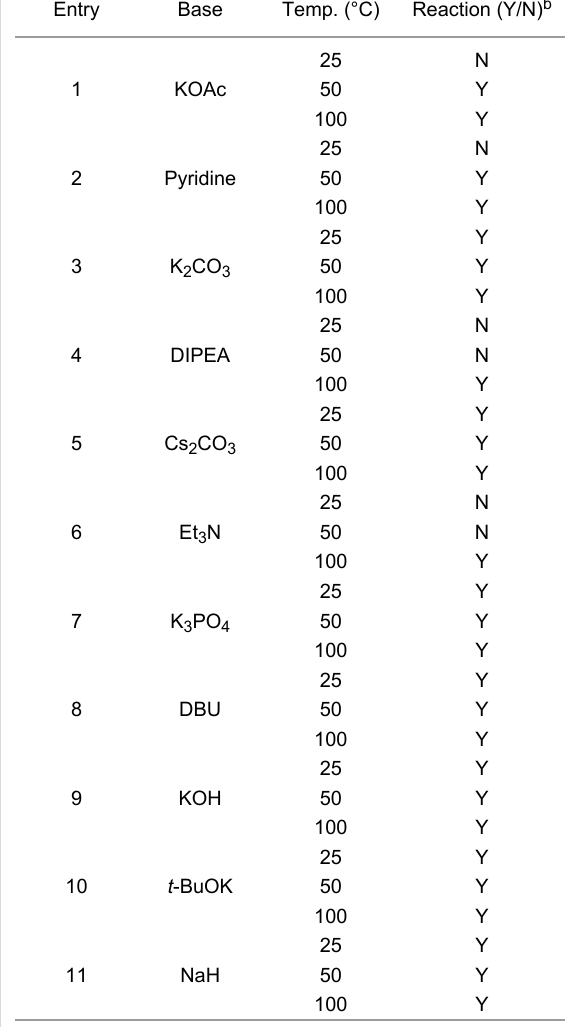
Table 2: Evaluation of the base sensitivity of Cyrene. a